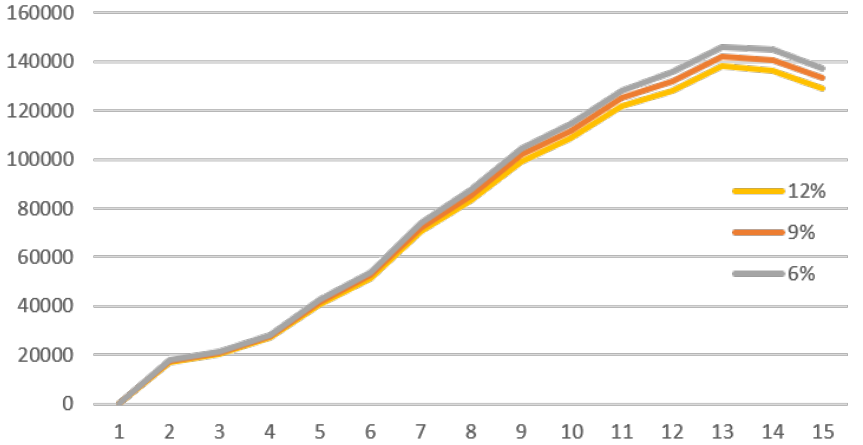
Figure 5. Comparative results for the different β legal for the UAM population.